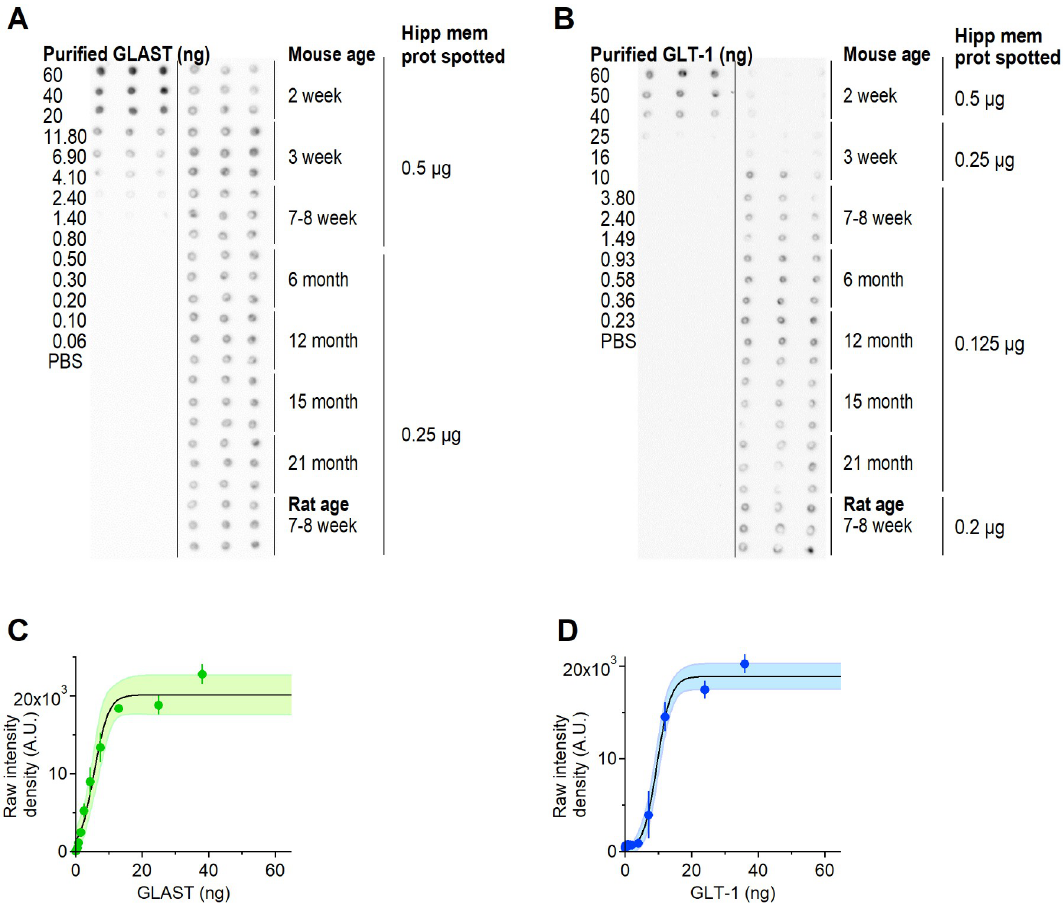
Fig 1. Dot blot analysis of GLAST and GLT-1 expression in the mouse hippocampus. A . Dot blots of recombinant and native GLAST in hippocampal membrane protein extracts from mice aged from 2 weeks to 21 months, and rats aged 7–8 weeks. B . As in A, for GLT-1. C . Sigmoidal fit of dot intensity for different amounts of recombinant GLAST. Each dot represents the mean ± SD (n = 3). D . As in C, for GLT-1.